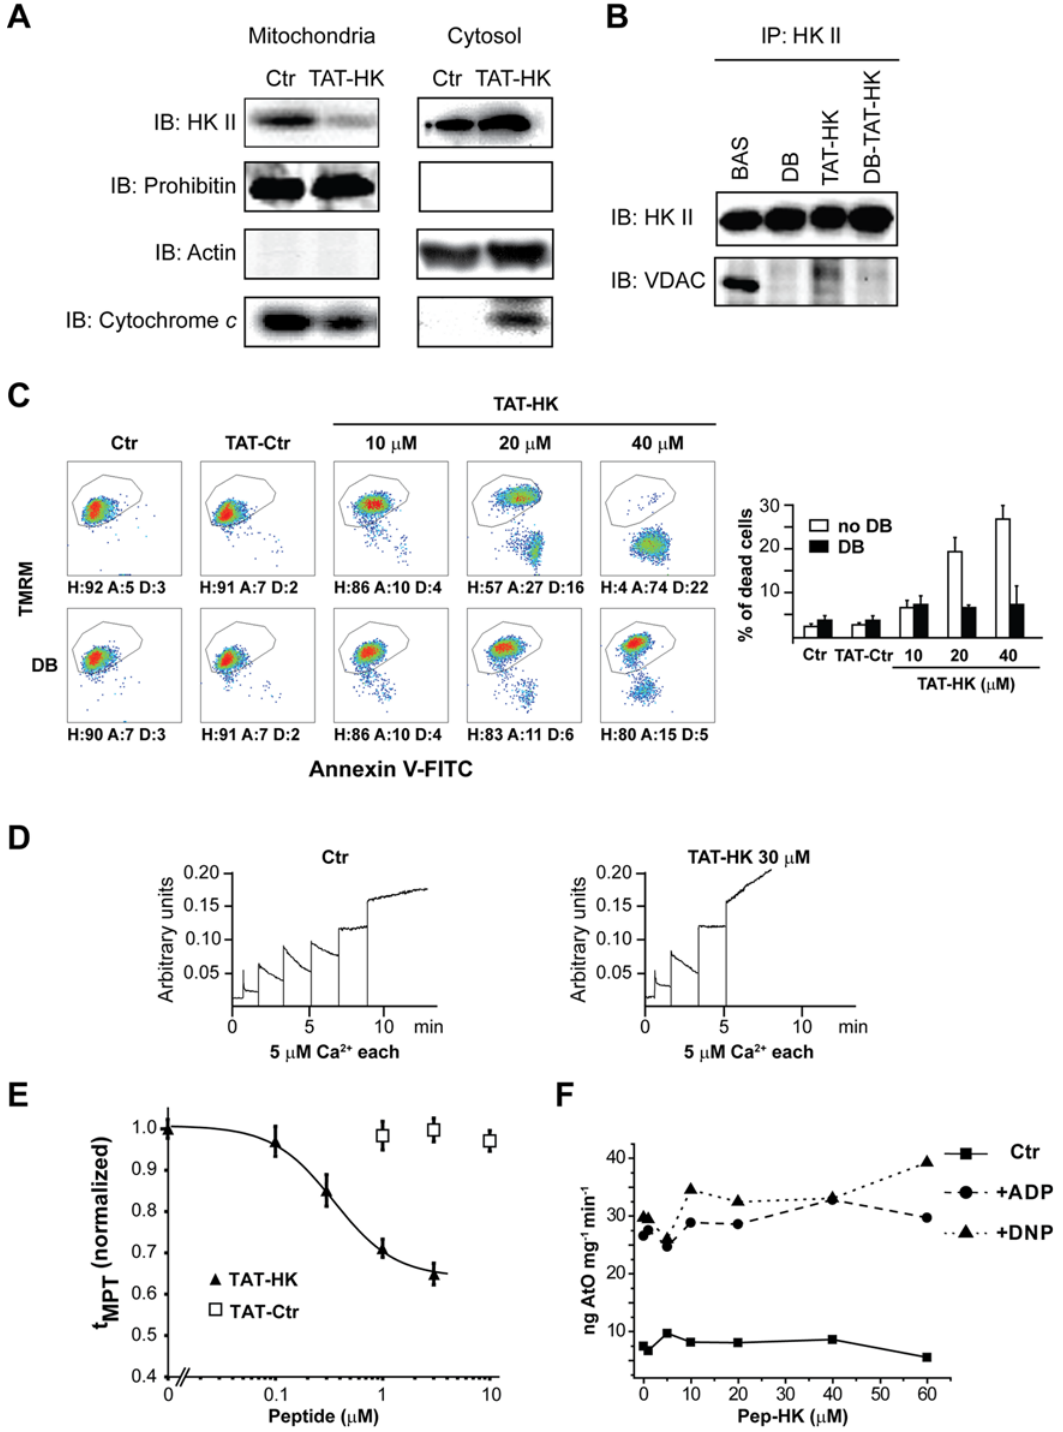
Figure 2. Selective detachment of HK II from mitochondria induces PTP opening and cell death. (A) HK II detachment from mitochondria of HeLa cells following a 1-hour treatment with TAT-HK (20 m M). Western immunoblots of a mitochondrial and of a cytosolic fraction show a redistribution of both HK II and cytochrome c into the cytosol. Blots were also probed with prohibitin as a mitochondrial marker and with actin as a cytosolic marker to check for fraction purity. (B) HK II immunoprecipitation in HeLa cells kept in control conditions or treated for 1 hour with Debio 025 (DB, 8 m M), TAT-HK (20 m M), or both. Co-immunoprecipitation of VDAC is shown. (C) Output of multiparametric FACS analyses show apoptosis induction of HeLa cells exposed for 2 hours to a control peptide linked to the TAT sequence (TAT-Ctr, 40 m M) or to the reported concentrations of TAT-HK with or without pre-incubation with Debio 025 (DB, 8 m M). Diagrams and percentages of the different cell populations are as in Fig. 1B. (D) PTP opening of digitonized HeLa cells measured with the Ca 2 + retention capacity assay. Experiments were started by the addition of cells (not shown) followed by pulses of the indicated concentrations of Ca 2 + ; where indicated, TAT-HK (30 m M) was added to cells 45 minutes before permeabilization